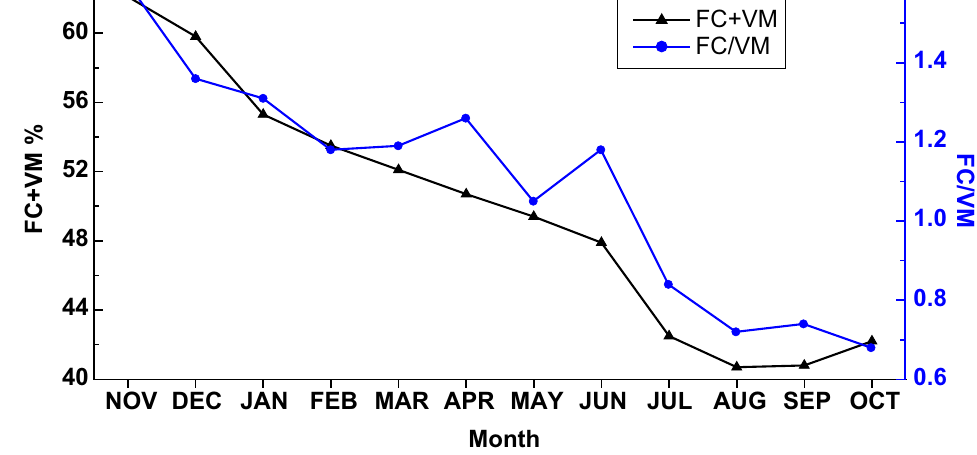
Fig. 3 Variation of FC ? VM and FC/VM through the year